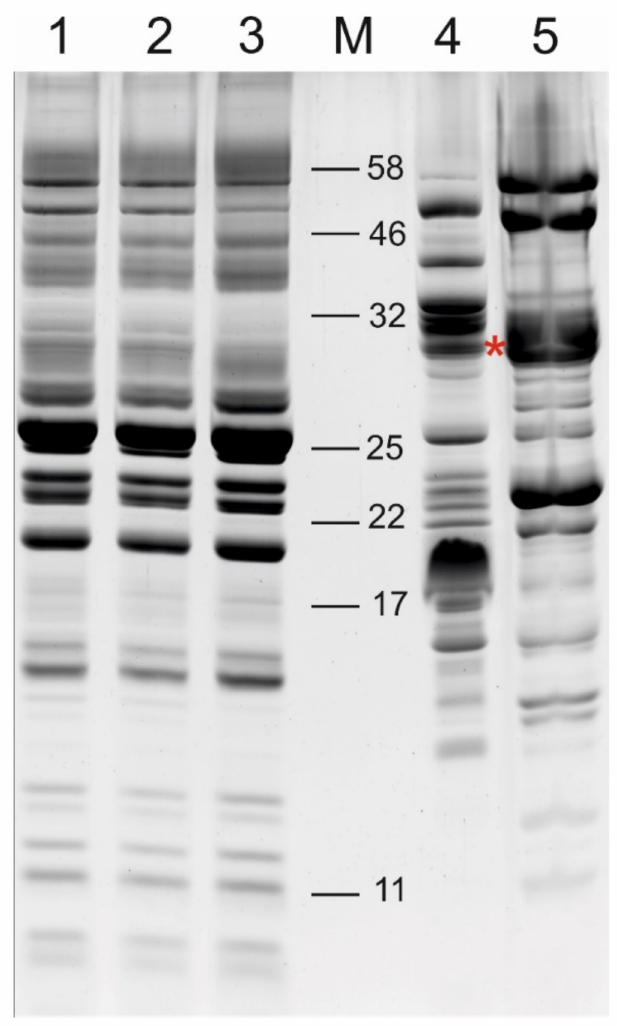
Figure 1. Thylakoid membrane and lumen fractions isolated during lumen preparations. SDS-PAGE separation of proteins stained with SYPRO Ruby. 1—total thylakoids; 2—thylakoid membranes after removal of the free lumen fraction; 3—thylakoid membranes after removal of the membrane- associated lumen fraction; 4—free lumen; 5—membrane-associated lumen; M—molecular weight marker. Lanes 1–3 contain 20 µ g protein, lanes 4–5 contain 100 µ g protein. Asterisk (*) indicates position of protein bands excised from FL and MAL fractions for PsbO1/PsbO2 analysis by selected reaction monitoring